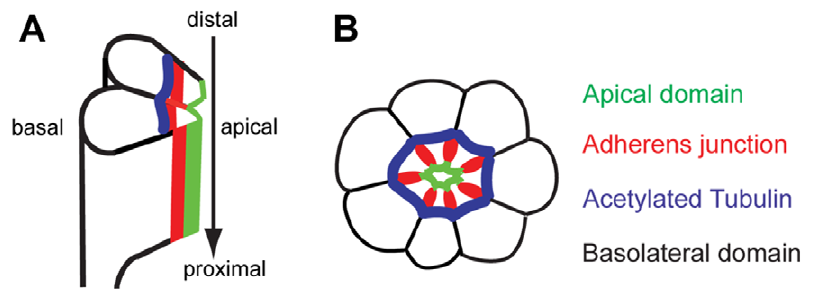
Figure 1. Morphogenesis of Drosophila pupal photoreceptors. (A) Side view of developing photoreceptors at 50% pupal development stage. The photoreceptors elongate from distal to proximal (arrow). (B) Cross-section of 50% pd pupal photoreceptors. Apical domain (green) localizes apical to AJ (red) in the center of a photoreceptor cluster. The E-cad localizes at AJ (red) which are more basal to the apical domain. The basolateral domains (black) are more basal to the AJ (red), and the acetylated-tubulin (blue) localizes at the outside from the AJs (red).